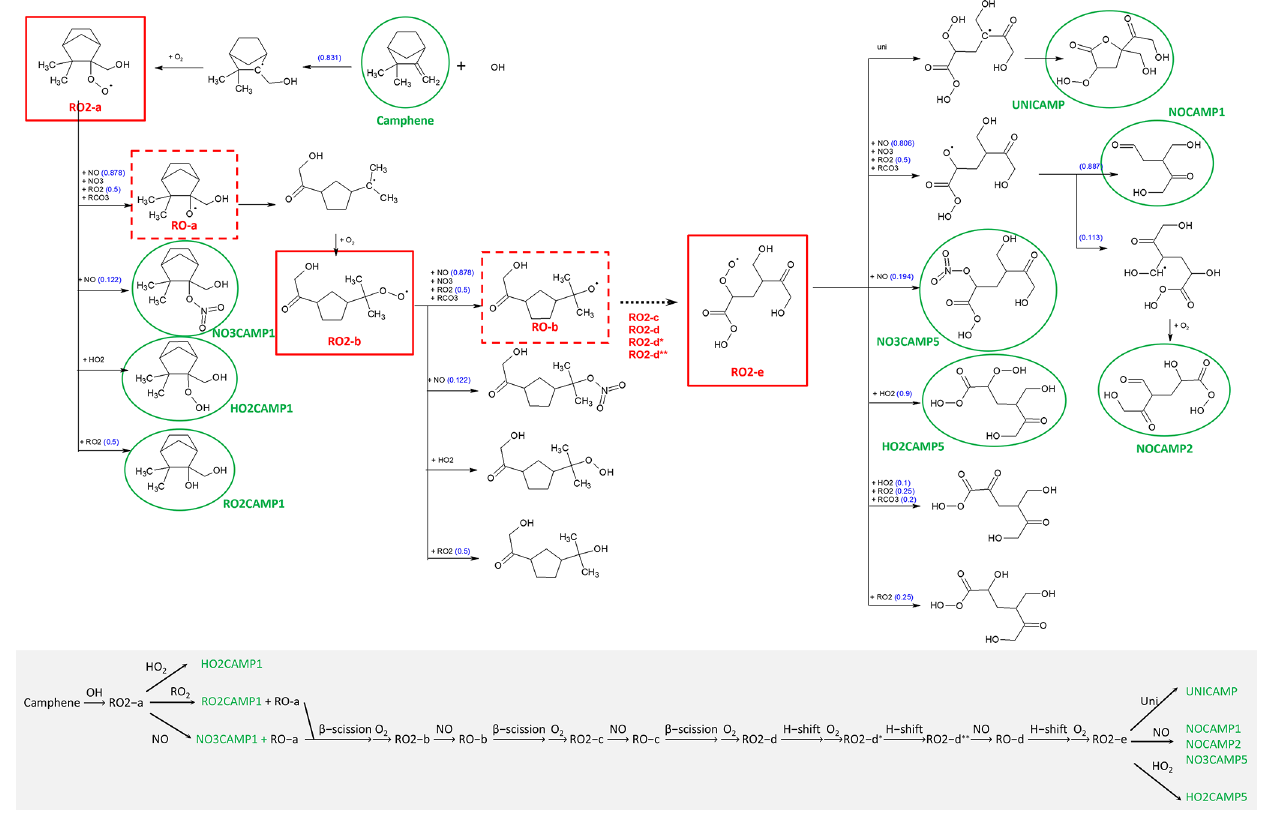
Figure 8. Schematic of the OH-initiated oxidation of the camphene mechanism in SAPRC at 298K and atmospheric pressure in the presence of NO x . See Fig. S4 for more details. Table 5. Log 10 C ∗ value for the selected first generation of stable end products formed from camphene reactions with